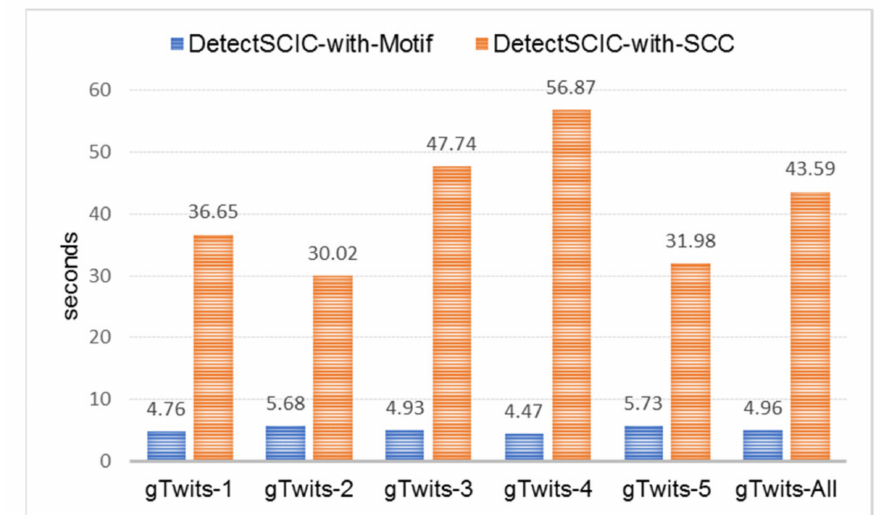
Figure 10. Execution time of detecting